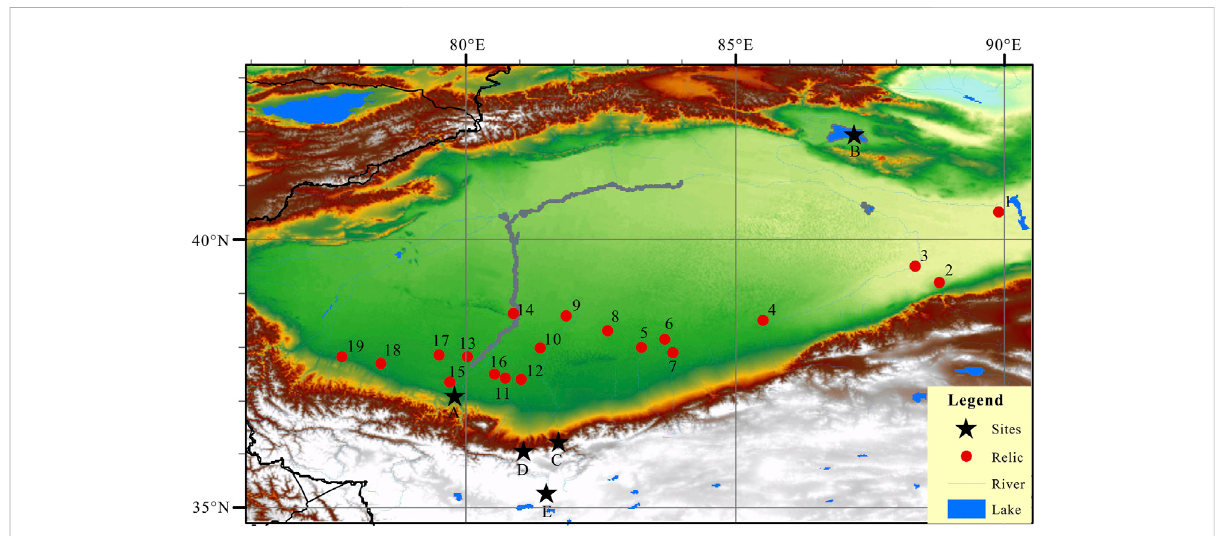
Distribution of ancient relics at the southern Tarim basin and the location of other sites referenced in the text. The numbers represent major ancient cities: 1) Loulan, 2) Miran, 3) Luobuzhuang, 4) Qiemo, 5) Andir, 6) Tiran, 7) Dawuzlek, 8) Niya, 9) Kelaton, 10) Dandanwulik, 11) Wucentoti,